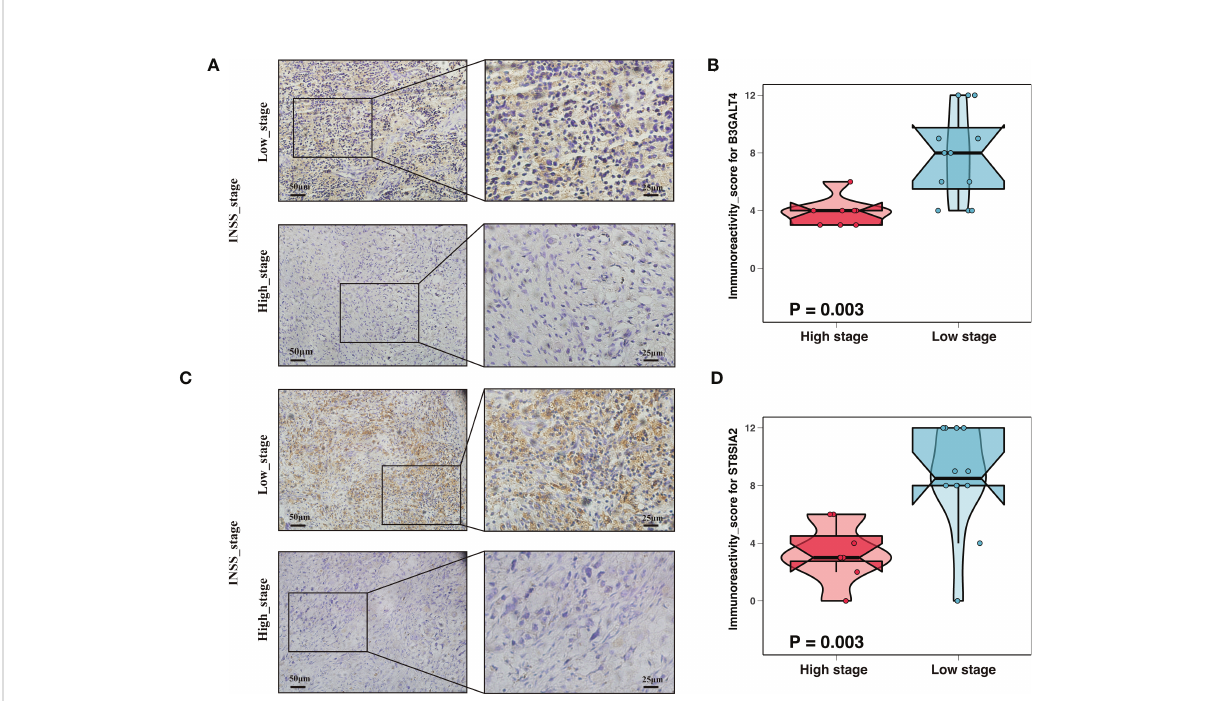
FIGURE 3 Expression validation of ganglioside-related genes by immunohistochemistry (IHC). (A) Representative IHC images showing the expression of B3GALT4 in different stages. Magni fi cation, ×200, ×400. (B) The comparison of B3GALT4 immunoreactivity score (IRS) between samples with high stage and low stage. (C) Representative IHC images showing the expression of ST8SIA2 in different stages. Magni fi cation, ×200, ×400. (D) The ST8SIA2 immunoreactivity score (IRS) comparison between samples with high stage and low